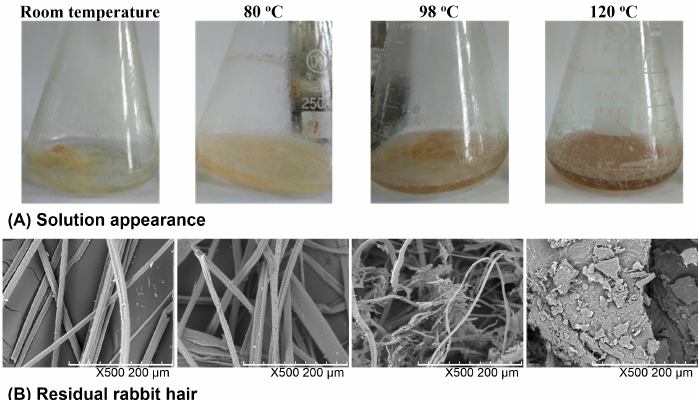
Figure 1. Appearance of the rabbit hair and DES mixture ( A ) and SEM images of residual rabbit hairs at various temperatures ( B ).